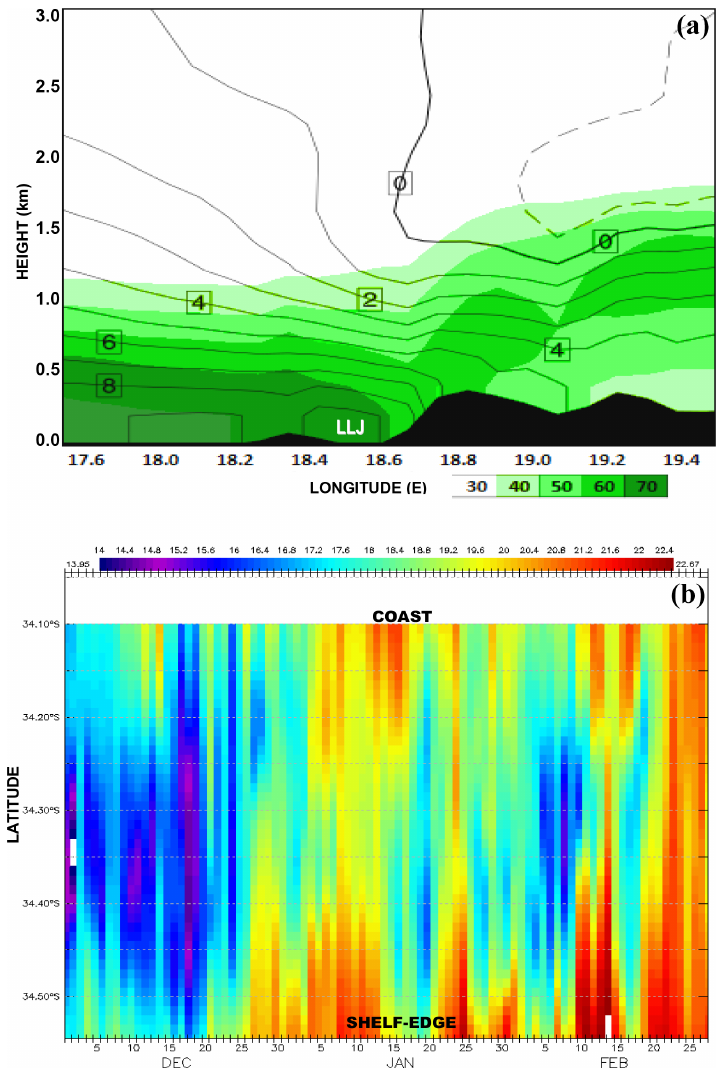
Figure A2. (a) downscaled WRF meridional wind isotachs and humidity % (shaded) in December 2012–February 2013, plotted in vertical section on 34.1 ◦ S, identifying the shallowness of equatorward flow, corresponding with Fig. 2c and d. (b) Hovmöller plot of daily 1km SST on 18.6 ◦ E, assimilated by GHR L4 satellite product, along the same line as Fig.